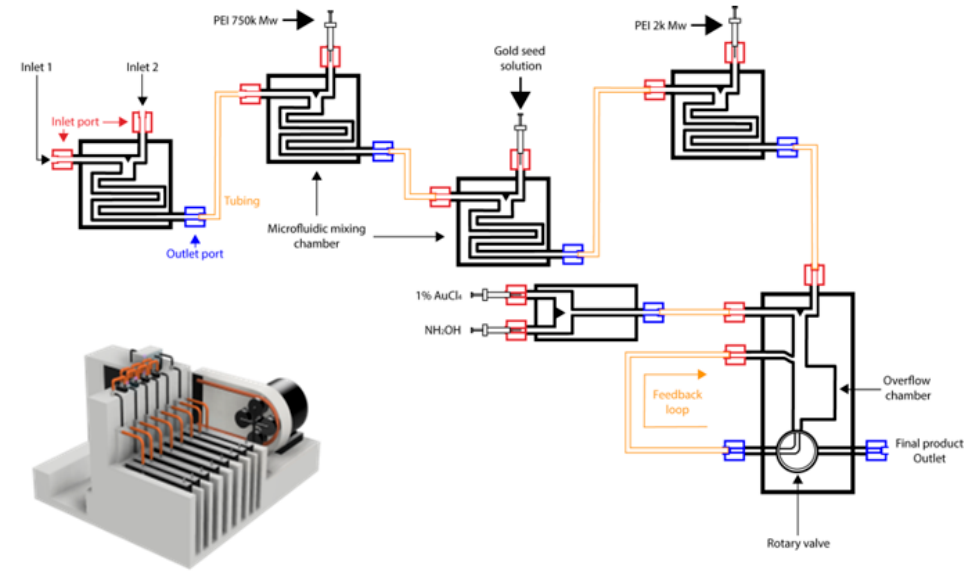
Figure 5. Proposed microfluidic setup for continuous manufacture of hybrid nanoparticles showing schematic representation and computer-aided design prototype.